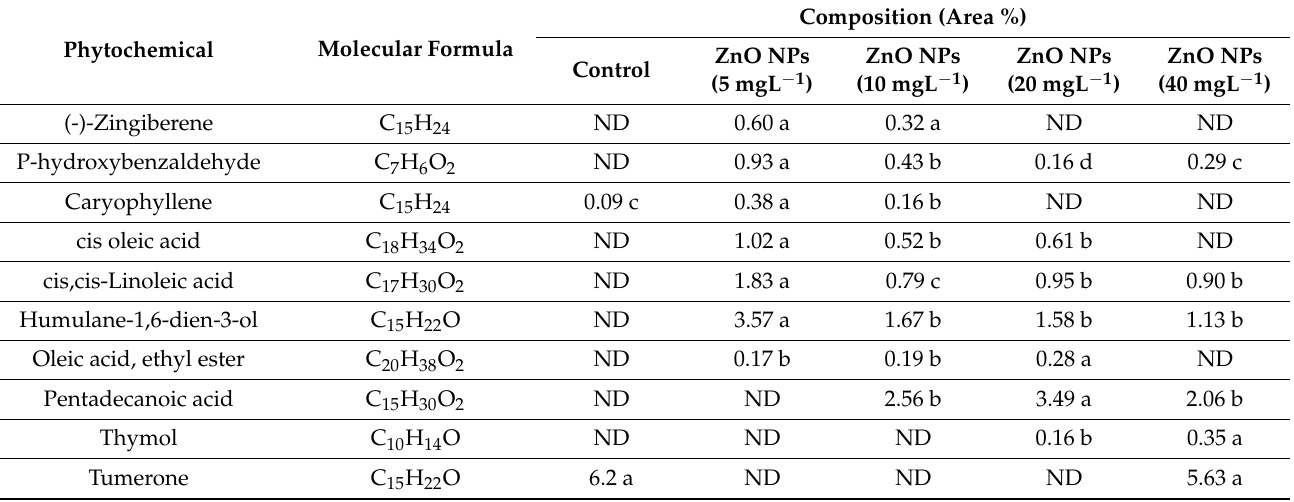
Table 7. Comparison of the compositions of unique compounds in the ethanolic rhizome extracts from C. longa plants of various experimental groups. Ethanolic extracts from three plants were measured to obtain the average value as presented. ND: not detected. Mean values followed by the same letter within a column are not significantly different at p = 0.05, as measured by Duncan’s test.